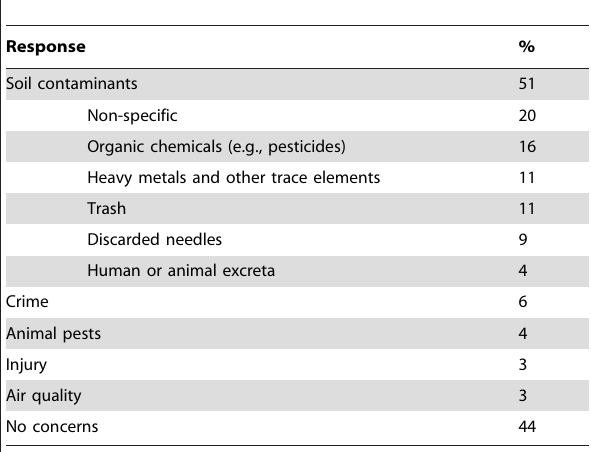
Table 2. Open-ended responses to ‘‘As a community gardener, do you have any concerns about hazards to your